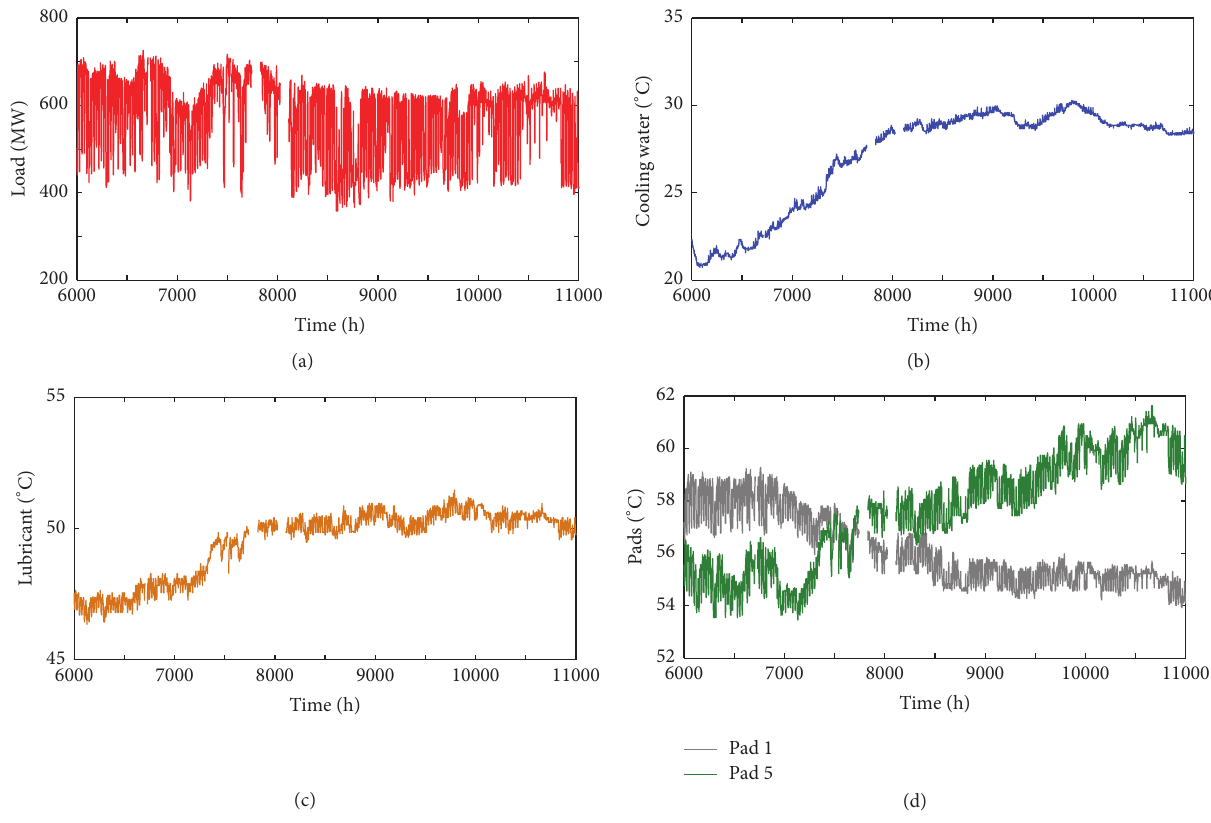
Figure 12: Generator load (a), cooling water temperature (b), lubricant temperature (c), and temperatures of two pads 90 ∘ apart from each other (d) of a LHG lower journal bearing.